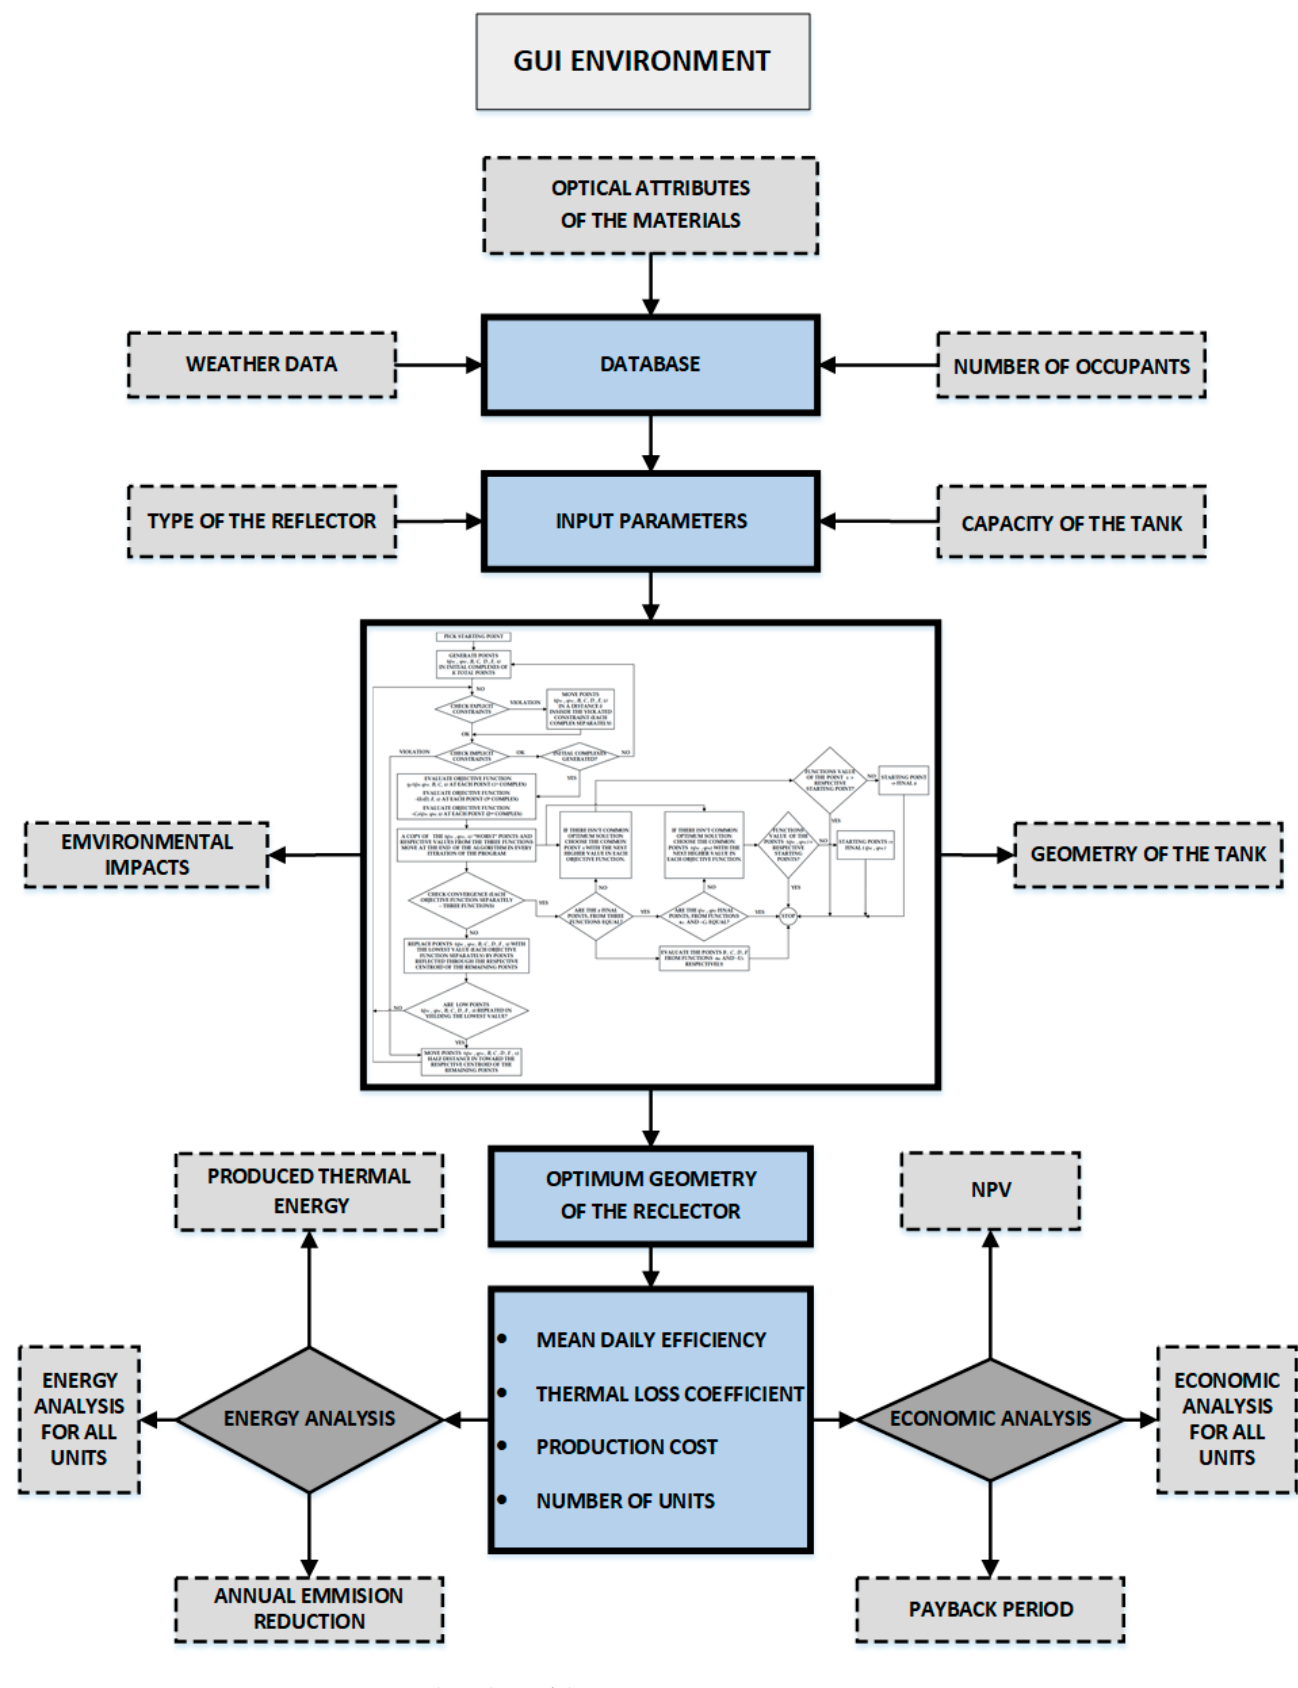
Figure 4. Flow chart of the program.